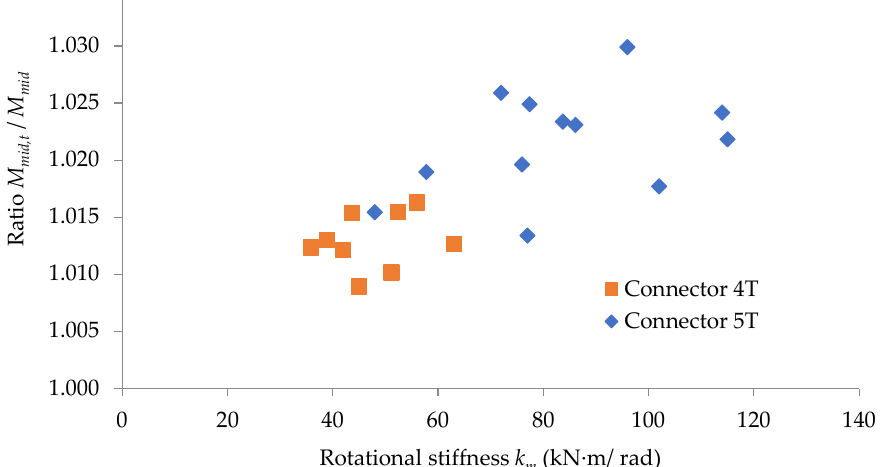
Figure 15. Variation of the ratio M mid , t / M mid related to the rotational stiffness k m of the connection for each type of tabs connector involved.